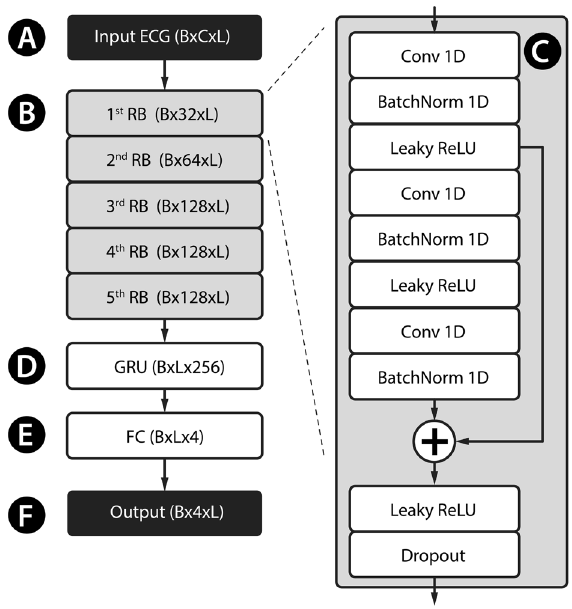
Figure 5. Architecture of the presented neural network. Standardized input ECG ( A ) enters the first Residual Block (RB). Five of RBs are chained together ( B ). RB is described in further detail in ( C ). Then the signal enters Gated Recurrent Unit (GRU, D ) layer, Fully connected layer (FC, F ) and transposition ( F ). B × C × L refers to batch size x channel count x signal